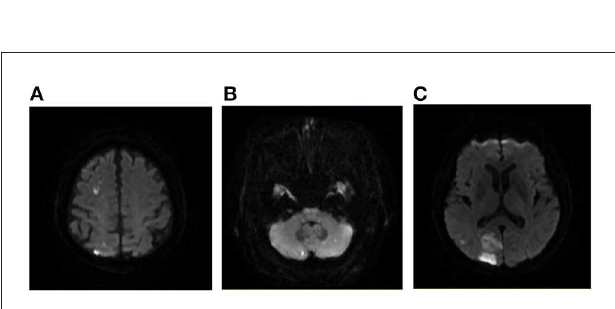
FIGURE4 A case of AMIMCT caused by cardiogenic embolism. A 76-year-old man with atrial fibrillation developed left homonymous hemianopia, left upper limb weakness, and ataxia. The lesions involved right frontal, parietal, and occipital lobes and bilateral cerebellar hemispheres (A–C) .